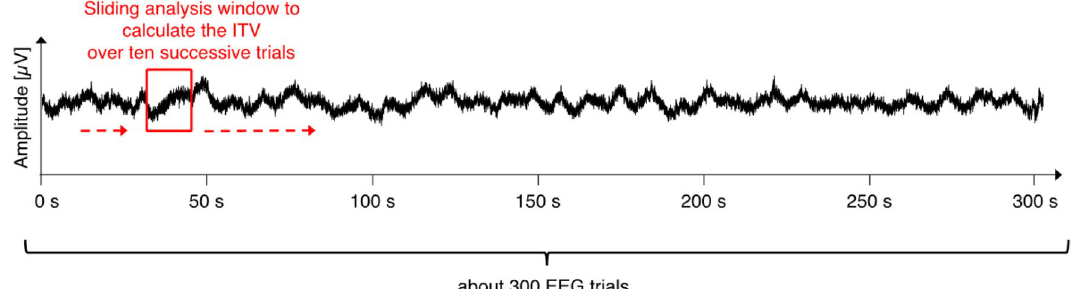
Figure 6. ETV calculation. The black fluctuating trace represents the raw EEG trace from the occipital electrode of one example participant observing repeated checkerboards and gray screens over a time course of 5 min. The evolving inter-trial variability (ETV) corresponds to calculation of the average of the ITVs over time within a sliding (indicated by the red dashed arrows) time window encompassing ten successive EEG trials (indicated by the red rectangle). This calculation results in the evolution of the average ITV over the whole experiment (i.e., 5 min or 300 EEG trials), thus reflecting EEG variability at a coarser timescale, compared to